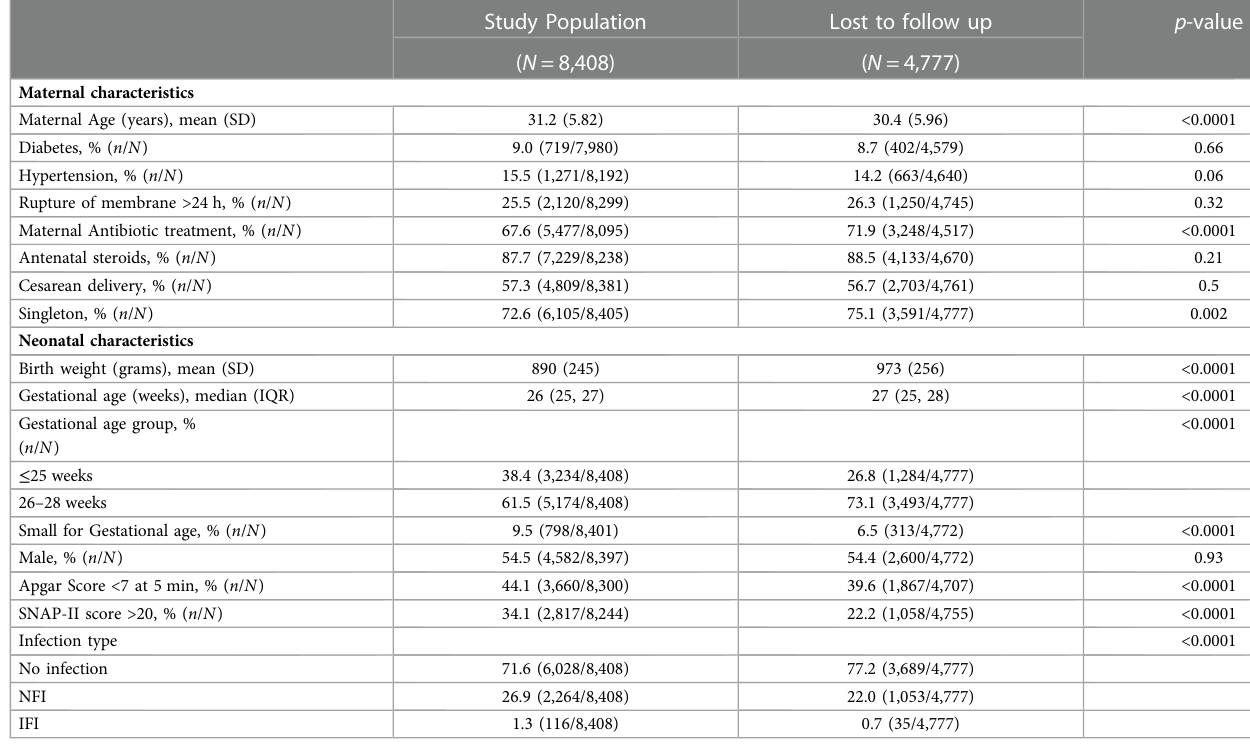
TABLE 1 Comparison of characteristics between infants included in the study population and those lost to follow-up. Study Population Lost to follow up p -value ( N = 8,408) ( N = 4,777)